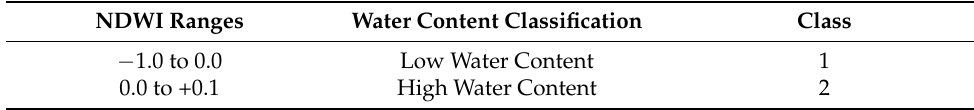
Table 3. NDWI ranges for Water Content